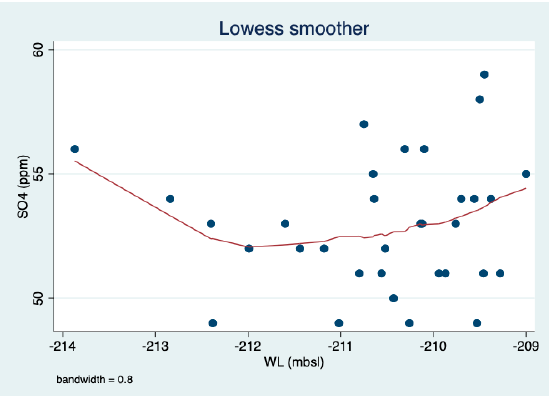
Figure 12. Trend of changes (Lowess smoother, 0.8 bandwidth) of annual lake averages of ammonium concentration (ppm scale range: 0.1–0.25) vs. WL (mbsl) during 1969–2001.